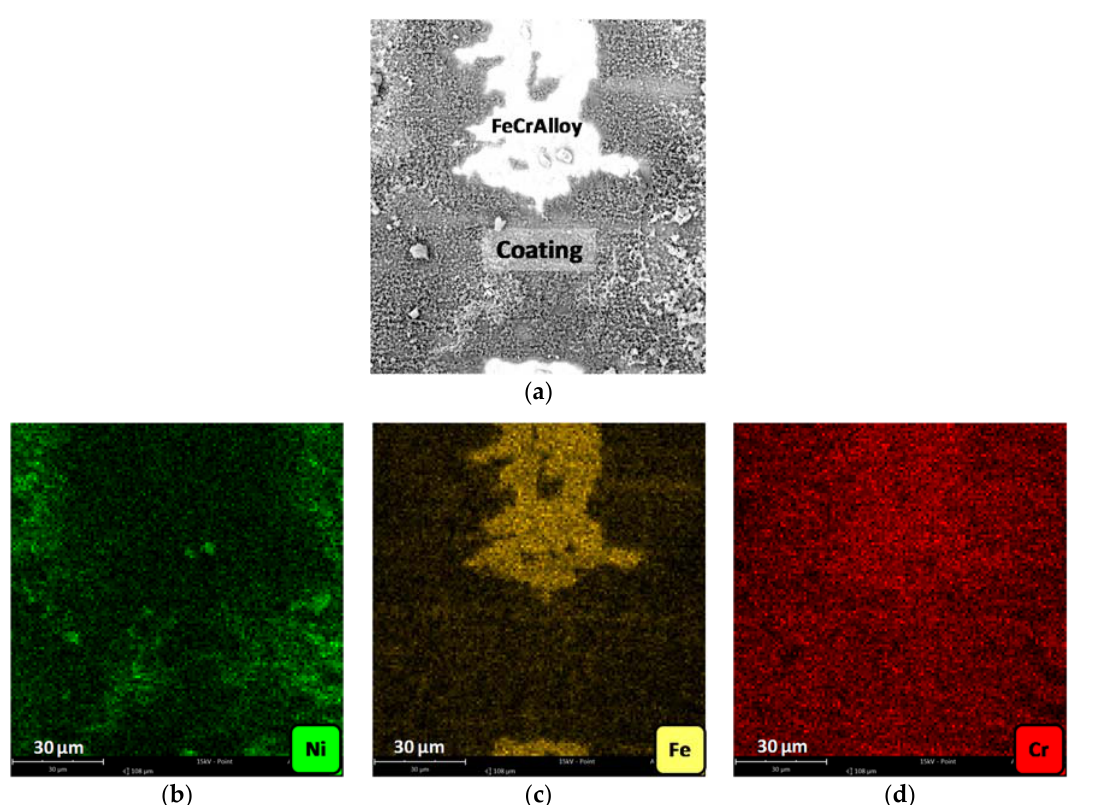
Figure 5. Mappings in an area of the Ni-Al-M1 structured catalyst: ( a ) SEM micrograph of the studied area, ( b ) Ni mapping, ( c ) Fe mapping and ( d ) Cr mapping.